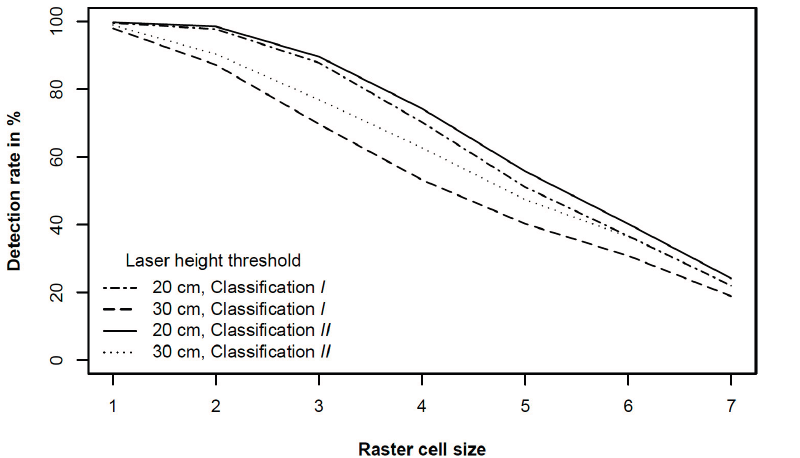
Figure 6. Detection rate for different raster cell sizes from